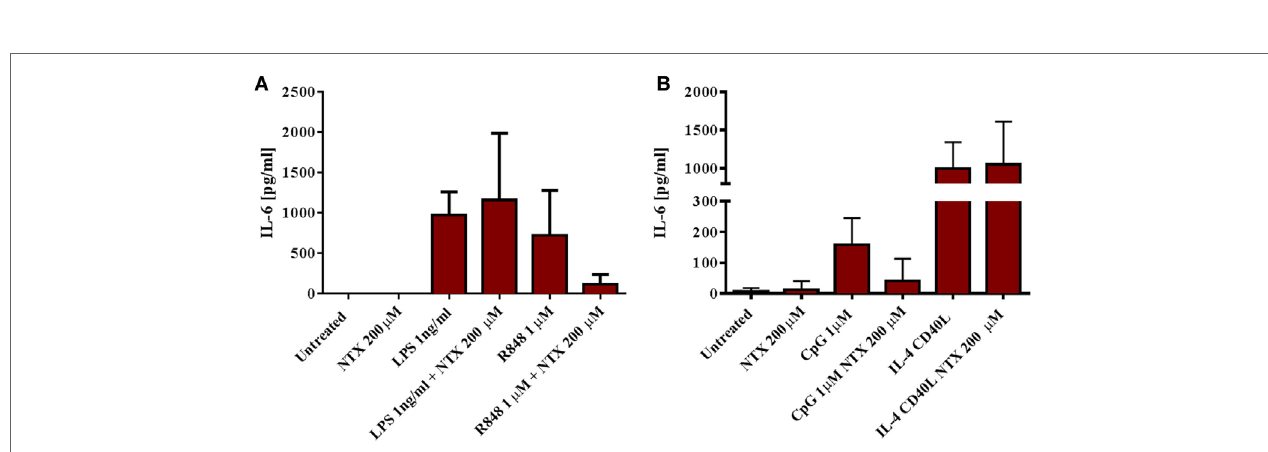
FigUre 3 | Naltrexone inhibits IL-6 production in isolated monocytes and B cells after toll-like receptor (TLR)7/8 and TLR9 stimulation, respectively, but has no effect on IL-6 production in isolated monocytes after TLR4 stimulation. (a) CD14 + monocytes were isolated from peripheral blood mononuclear cells (PBMC) using magnetic bead isolation. 1 × 10 5 CD14 + cells were incubated with 1 ng/ml LPS (TLR4-L) or 1µM R848 (TLR7/8-L), in the presence or absence of 200µM naltrexone for 24 h. Cell-free supernatants were collected and analyzed for IL-6 by ELISA. (B) CD19 + B cells were isolated from PBMC using magnetic bead isolation. 10 5 B cells were incubated with 1µM CpG or 3 µg/ml CD40-L and 20 ng/ml IL-4, with or without 200µM naltrexone for 24 h. IL-6 production was measured in cell-free supernatants by ELISA. Data show the mean and SD values ( n = 4).